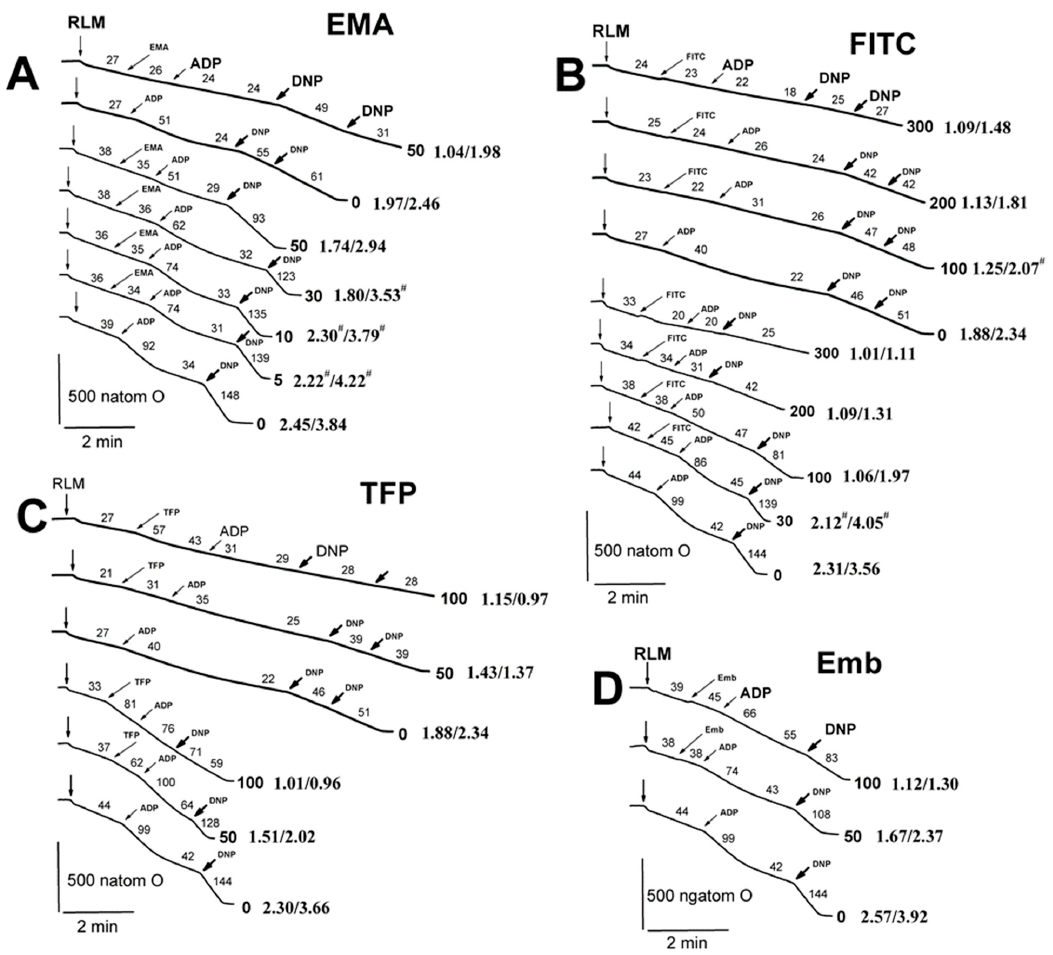
Figure 8. The influence of EMA, FITC, TFP, Emb and Ca 2+ on oxygen consumption rates of rat liver mitochondria in the medium with 25 mM TlNO 3 . Mitochondria (1.5 mg/mL of protein) were injected into the medium B containing 5 mM succinate. Arrows show additions of mitochondria (RLM), 0– 50 μ M EMA (EMA), 0–300 μ M FITC (FITC), 0–100 μ M TFP (TFP), 0–100 μ M embelin (Emb), 130 μ M ADP (ADP), and double 15 μ M DNP (DNP). Oxygen consumption rates (natom O min/mg of pro- tein) are presented as numbers placed above experimental traces. The numbers in Arial and bold on the right of the traces show concentrations ( μ M) of EMA ( A ), FITC ( B ), TFP ( C ), and Emb ( D ). The numbers in Times New Roman and bold on the right of the traces show the ratios of the RCR ADP and the RCR DNP values (see the Materials and Methods, and for more detail, see the Supplementary Data). Hash signs on the right of latter numbers indicate that differences between appropriate val- ues of the RCR ADP and the RCR DNP are statistically insignificant to the values found in experiments free of EMA, FITC, TFP, and Emb.